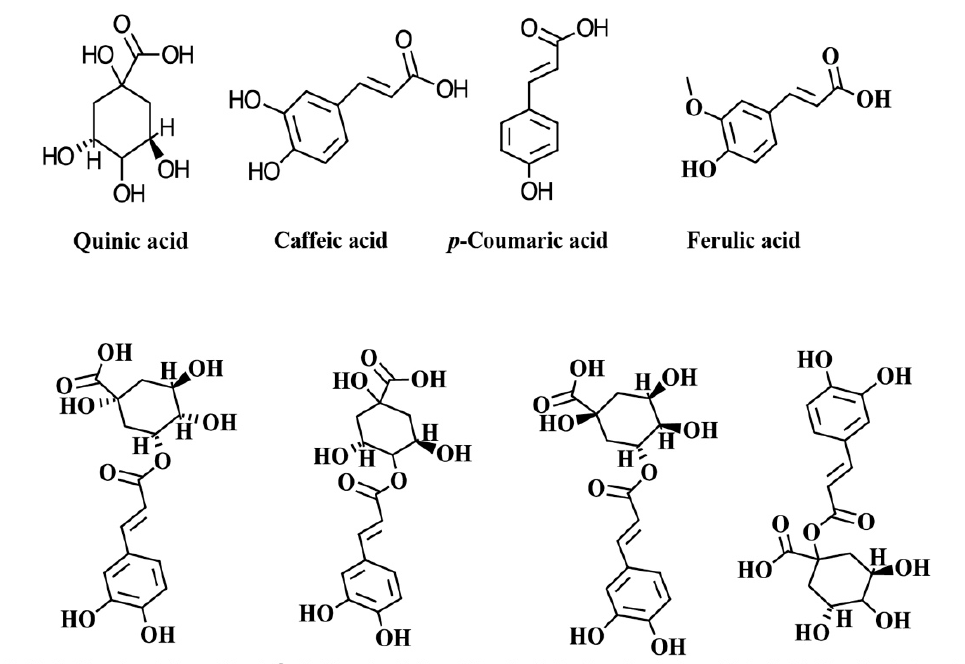
Figure 1. Chemical structures of main chlorogenic acids (CGAs) and isomers of caffeoylquinic acid.